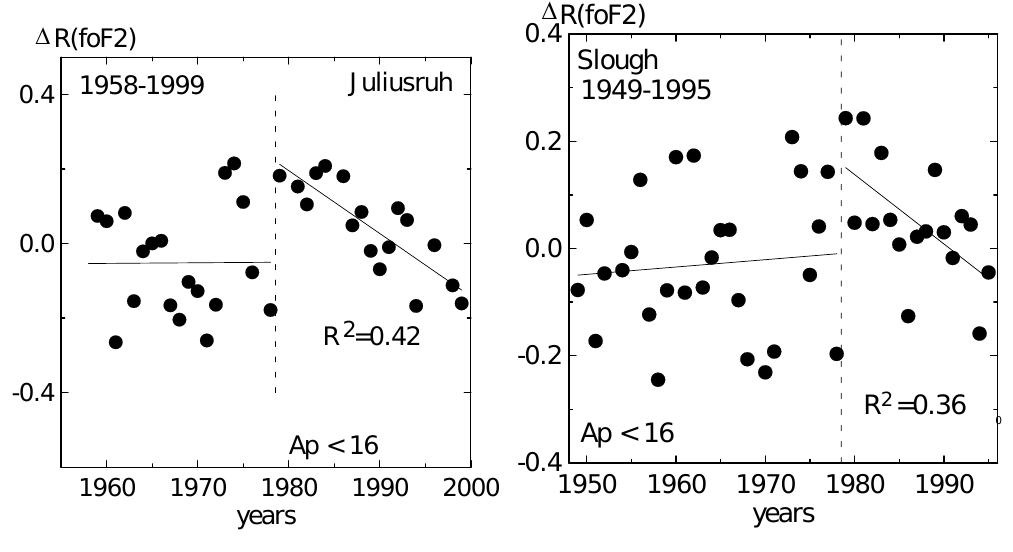
Fig. 5. Variations with time of the 1R ( fo F2) for Juliusruh and